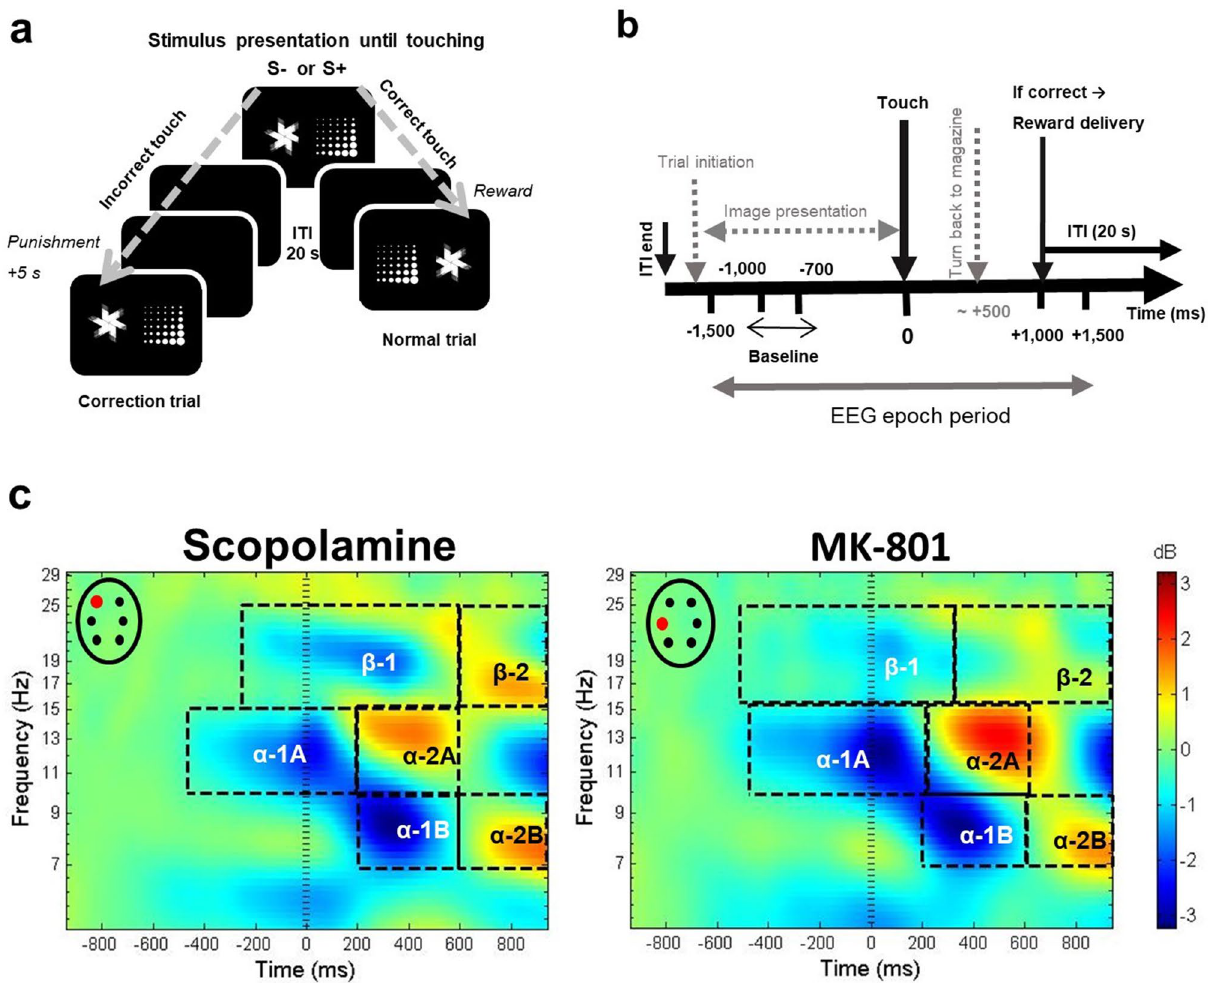
Figure 1. The touchscreen Visual Discrimination (VD) task combined with EEG. ( a ) Graphical illustration of the VD task. Rats discriminated two simultaneously presented visual stimuli on a computer-controlled touch screen. Correct (S+) responses were rewarded by a pellet, and a subsequent intertrial interval (ITI; 20 s) was followed by a normal trial with pseudorandom image positions. Incorrect (S −) responses were punished with a time-out period (5 s), no reward was given, and were followed by correction trials having the same image positions as in the preceding trial until the correct image was touched. Neither correct nor incorrect choices were followed by positive or negative feedback signals. ( b ) The EEG epoch timeline. EEG was time-stamped to touches (t = 0); the 3-s-long (peristimulus +/− 1500 ms) EEG epochs were spectrally decomposed to provide ERSP values. Solid and broken arrows mark events with fix timing and with putative time-course relative to 0, respectively. ( c ) Group average ERSP maps of scopolamine and MK-801 experiments. Plots show the mean time course of ERSP power (decibel, db) change relative to the baseline in the period from ~ 1000 ms before to ~ 1000 ms after the correct touch responses (t = 0) in the frequency range of 5–30 Hz averaged across all subjects and treatment conditions in the scopolamine (n = 9; map on frontal left electrode) and MK-801 experiments (n = 7; map on parietal left electrode) separately. Black rectangles indicate the time–frequency windows of interest. ERSP maps were created by the EEGLab toolbox of